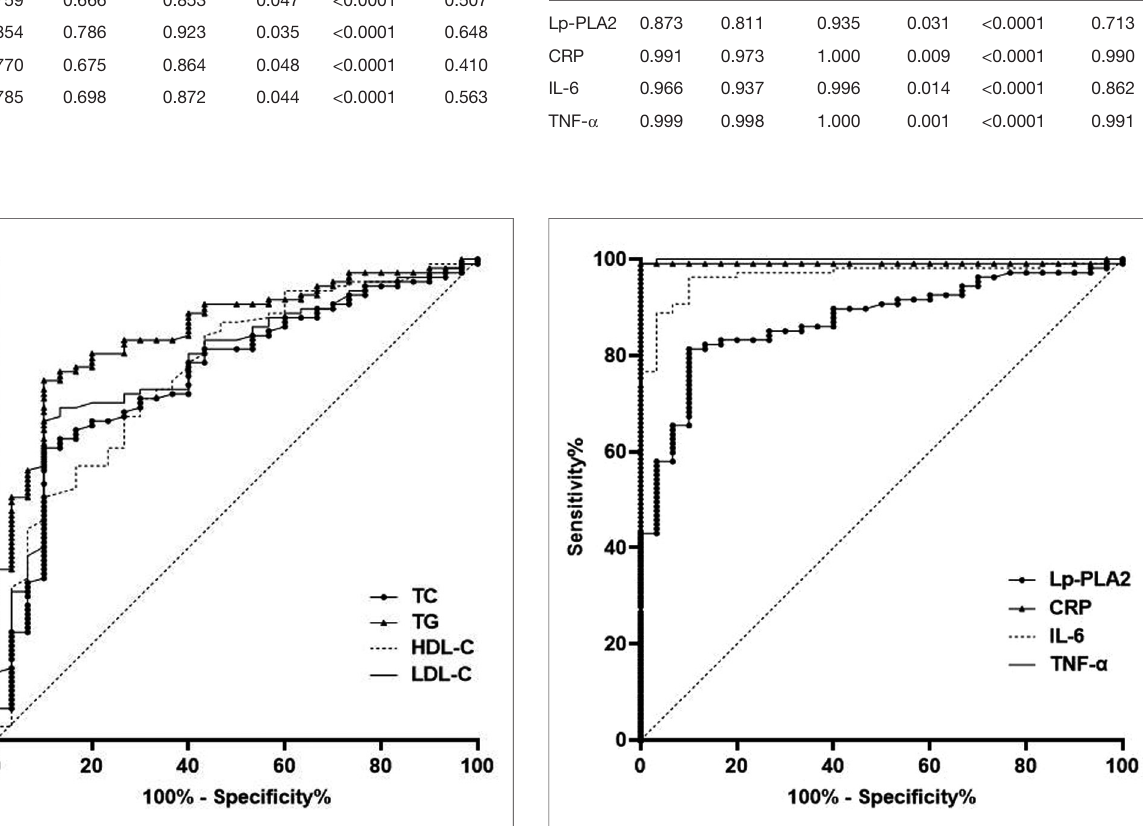
FIGURE 3 | Predictive value of blood lipid level in pregnant women with HDP.